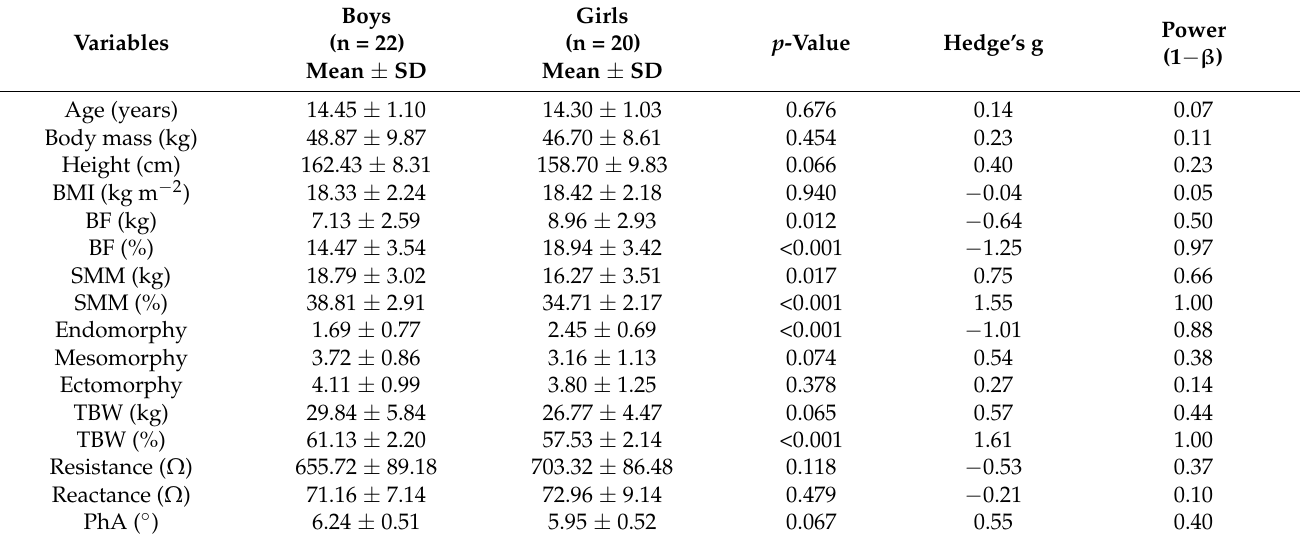
Table 1. Descriptive statistic and differences between the group of boys and the group of